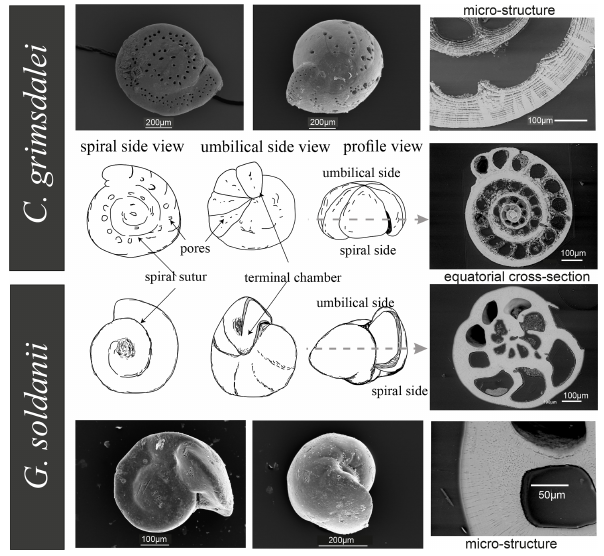
Figure 2. Comparison of Cibicidoides grimsdalei and Gyroidi- noides soldanii tests. Line drawings of different views in the centre. SEM images of spiral and umbilical site, equatorial sections and a close-up showing test structures. Dashed line = plane of largest diameter (equatorial